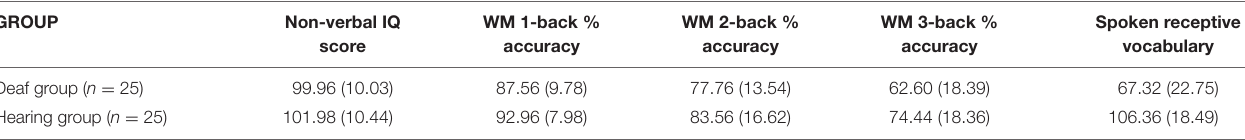
TABLE 2 | Total scores on cognitive skills and spoken receptive vocabulary size across deaf and hearing groups.